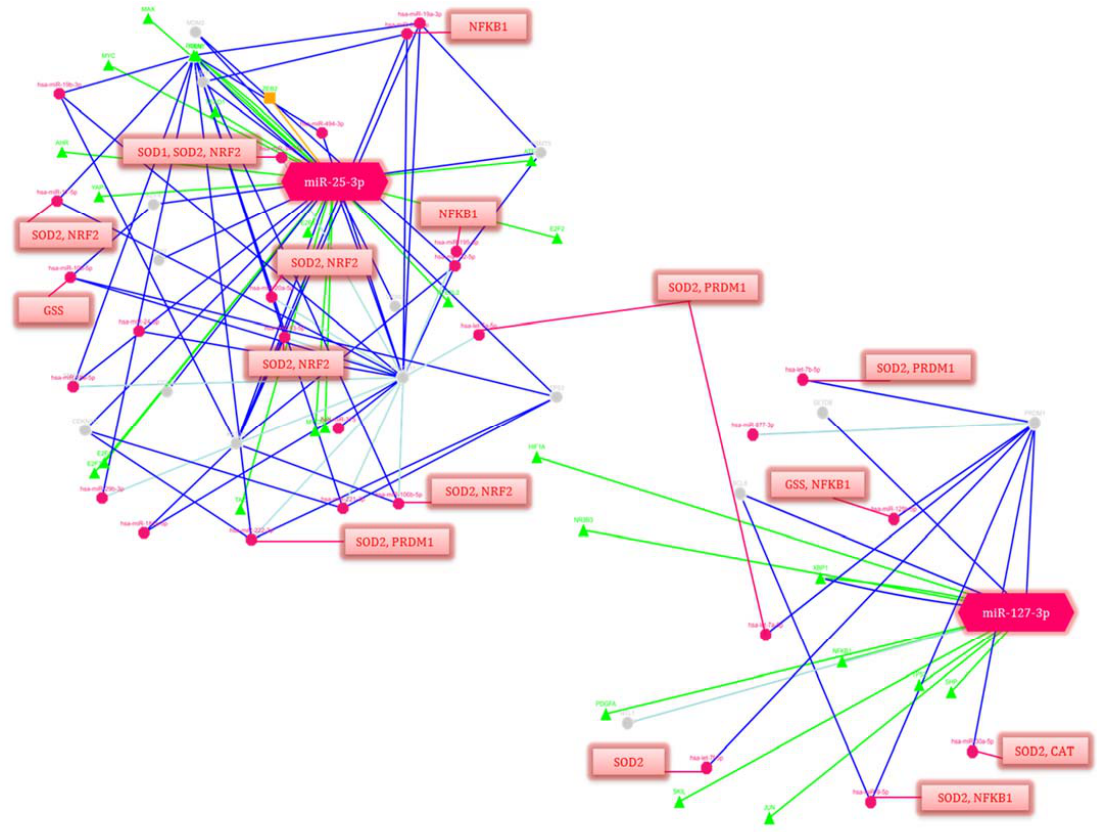
Figure 6. Regulation network of potential gene-targets of miR-25-3p and miR-127-3p ( p -value ≤ 0.05). Deep blue lines indicate strong evidence (e.g., reporter analysis, Western blot, qRT-PCR or qPCR). The green lines correspond to the regulation of transcription factors. Blue lines are other evidence. Triangles are transcription factors (TF), red circles are miRNAs, gray circles are genes regulated by miRNAs. The red lines indicate the regulation of genes isolated in blocks by these miRNAs. The decoding of the genes’ names is given in Table